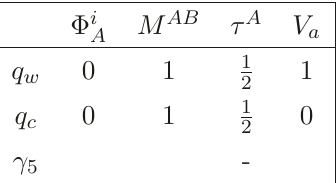
Table 5 . Non-linear